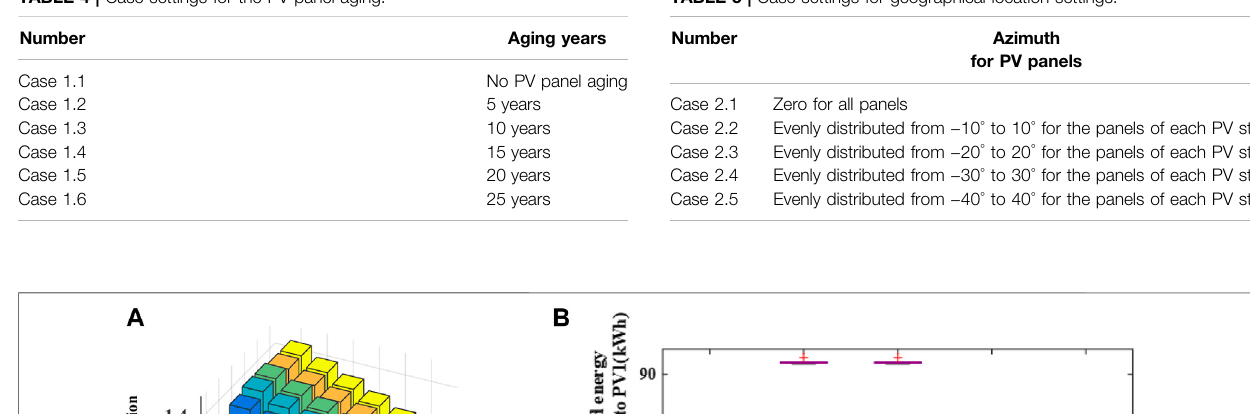
TABLE 4 | Case settings for the PV panel aging.